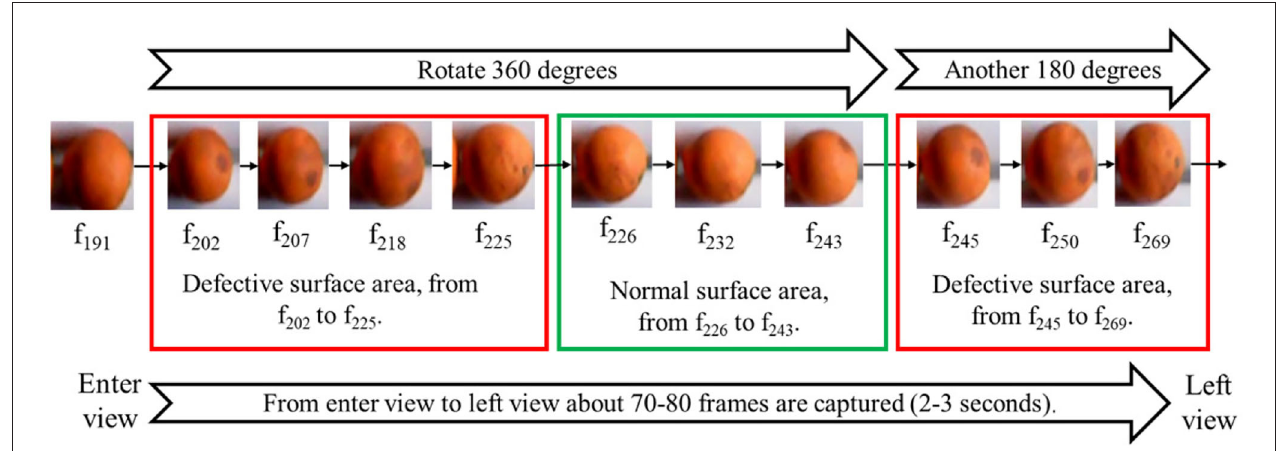
FIGURE 7 | The captured images of a defective orange in 2–3 s, which includes 78 images. The defective part exists in a series of neighboring frames.